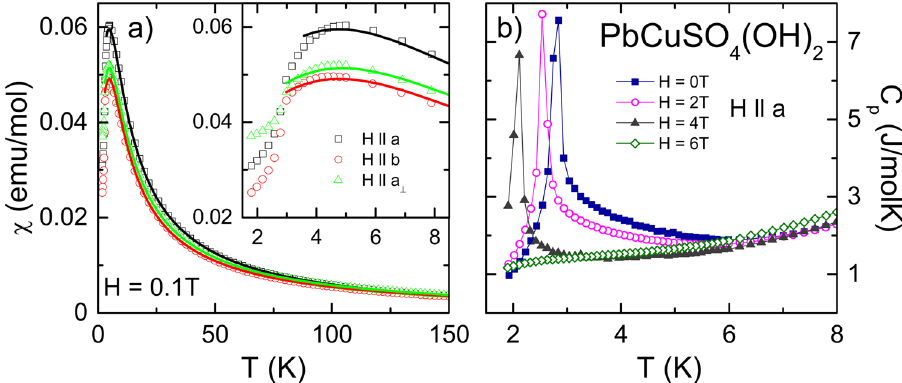
Figure 1. Magnetic susceptibility and specific heat measurements. ( a ) Temperature dependence of magnetic susceptibility χ of a PbCuSO 4 (OH) 2 single crystal with magnetic fields H = 0.1 T along a , b and a ⊥ directions. The lines represent fits with numerical Bonner-Fisher approximation. The inset shows a magnified view for T ≤ 9 K. ( b ) Temperature dependence of specific heat measured of a PbCuSO 4 (OH) 2 single crystal with magnetic field along a direction for various applied magnetic